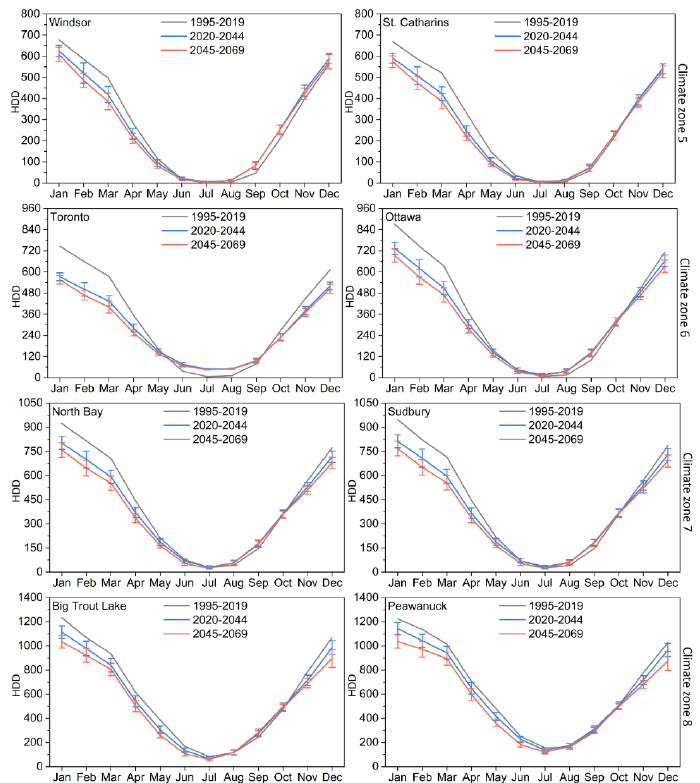
Figure 5. Historical (1995–2019) and future (2020–2069) monthly HDD for selected cities. Figure 5. CivilEng 2022 , 3 , FOR PEER REVIEW Historical (1995–2019) and future (2020–2069) monthly HDD for selected cities.